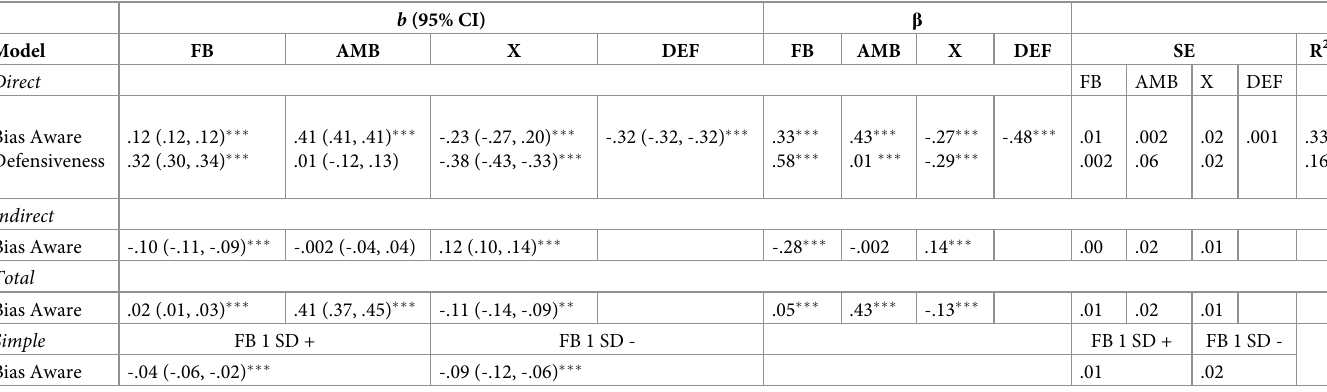
Table 2. Results from SEM for bias